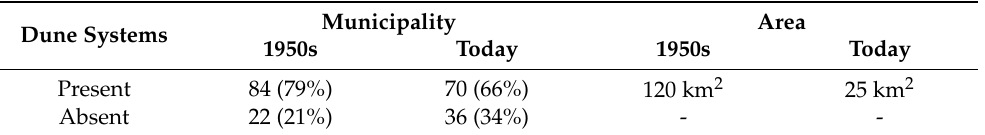
Table 2. Summary of the municipalities with dune systems present or absent in the 1950s and today, and a summary of the dune system extension in the 1950s and today.